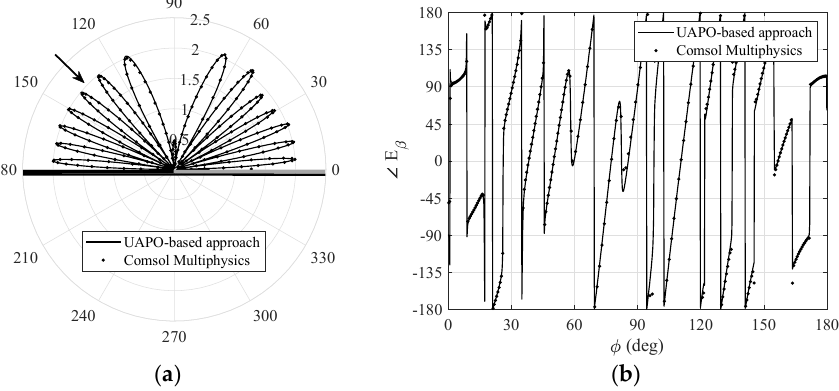
Figure 3. Case I: comparisons with Comsol Multiphysics ® data when φ (cid:48) = 60 ◦ , E i ( a ) Amplitude of the total field φ –component. ( b ) Phase of the total field φ –component.